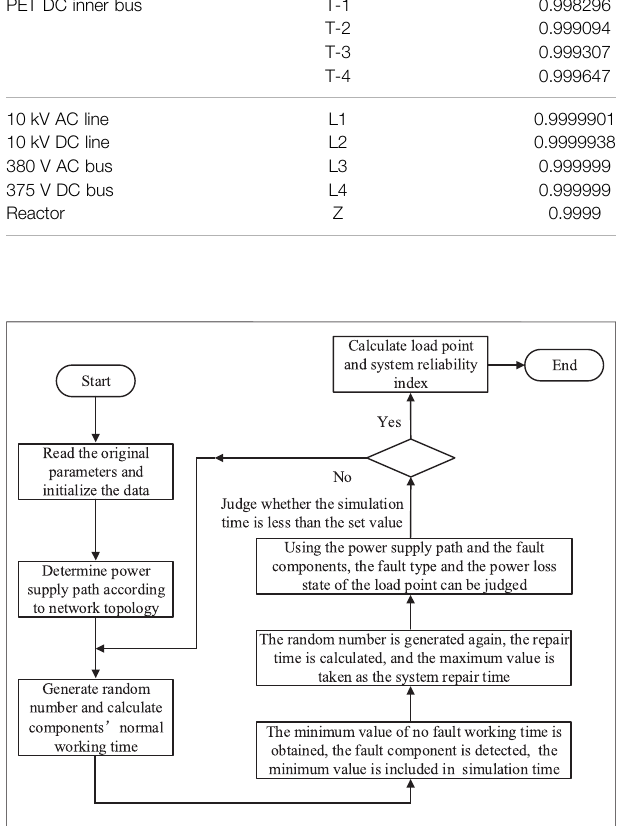
FIGURE 15 | Simulation calculation of power supply reliability based on the sequential Monte Carlo